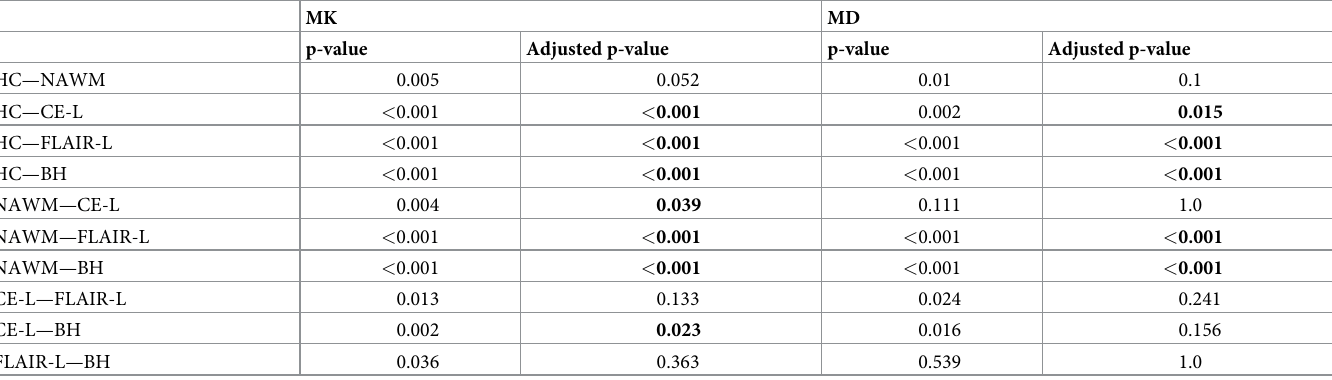
Table 2. Differences between MS lesion categories regarding MK and